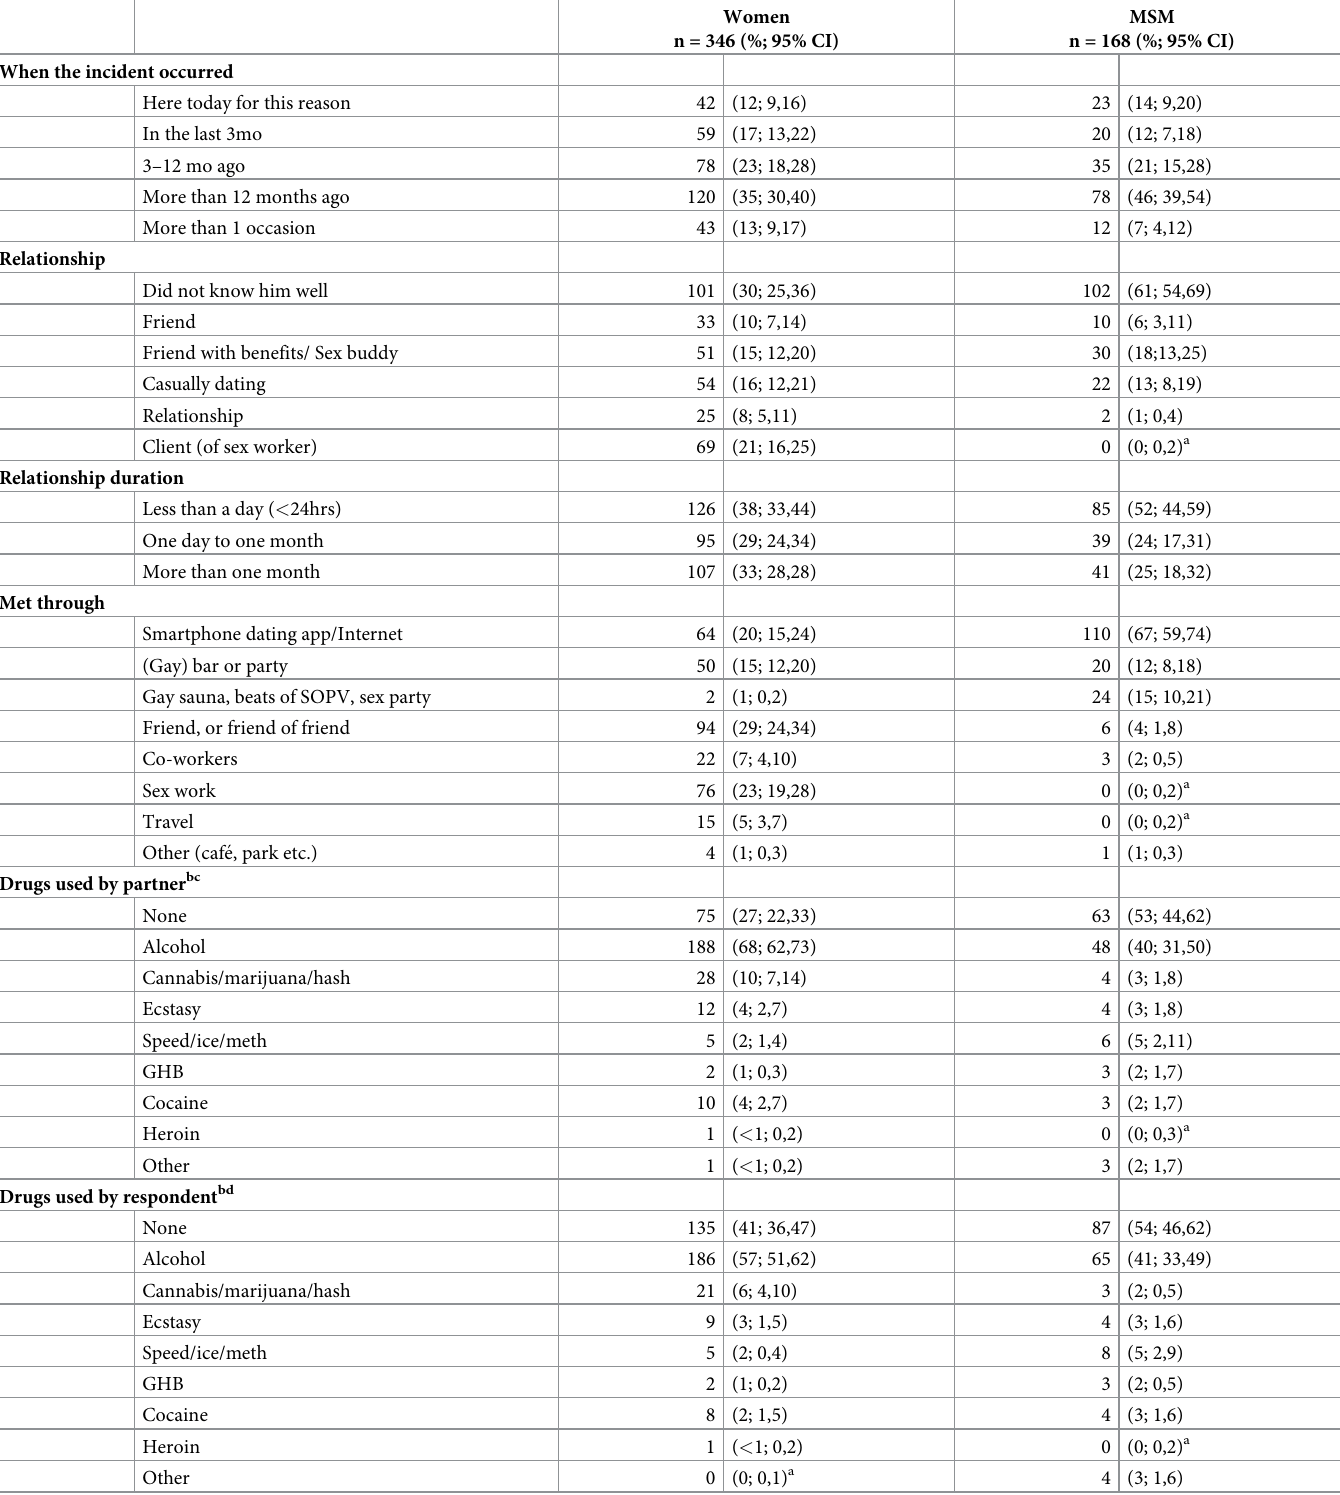
Table 4. Situational factors surrounding non-consensual removal of condoms (stealthing) reported by patients presenting to a STI clinic (N = 523).